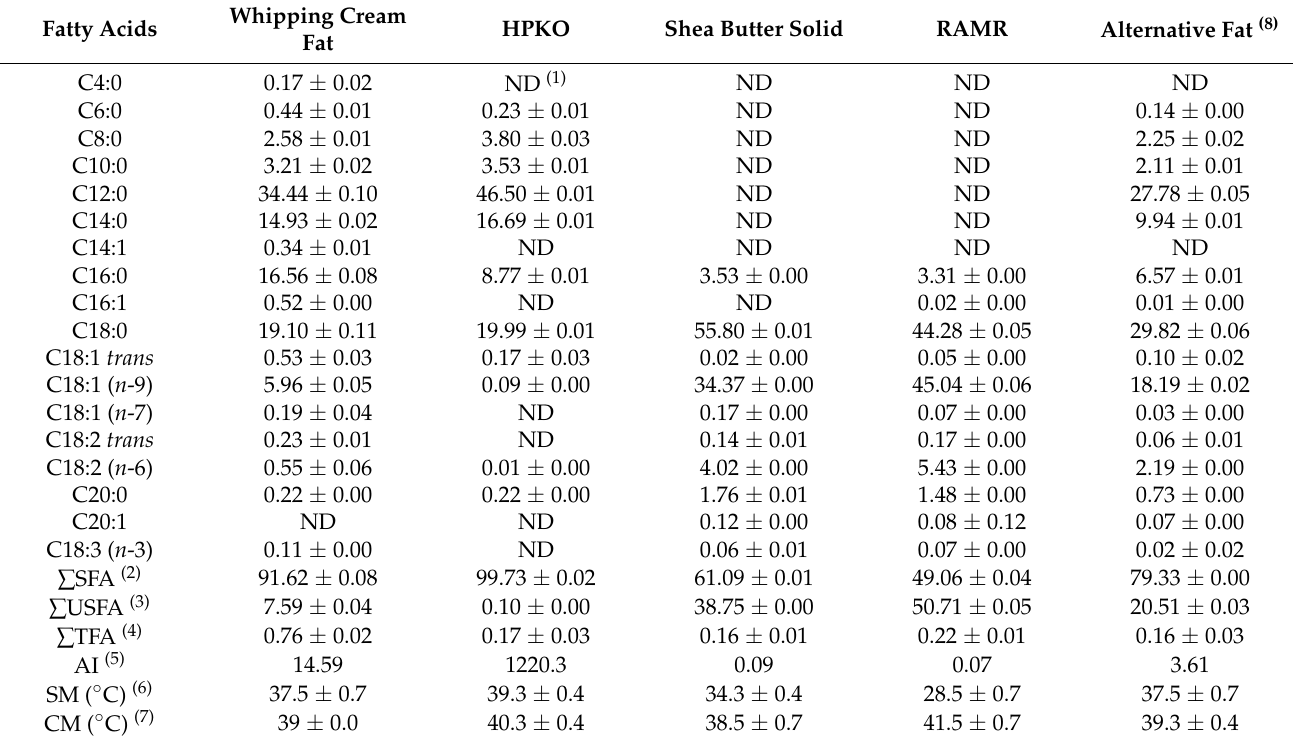
Table 3. Fatty acid composition, slip melting point (SM), and complete melting point (CM) of whipping cream fat, hydrogenated palm kernel oil (HPKO), shea butter solid, refined acyl migration reactant (RAMR), and alternative fat. (Unit: